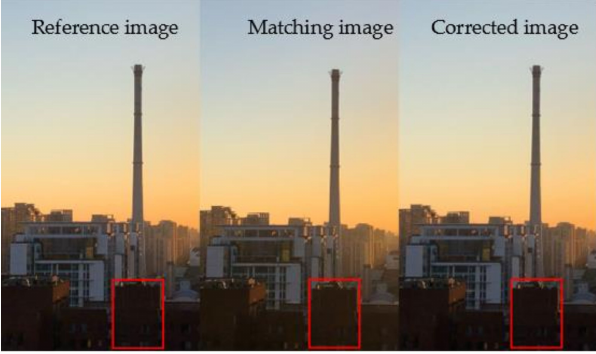
Figure 15. Color correction of matching image and reference image.